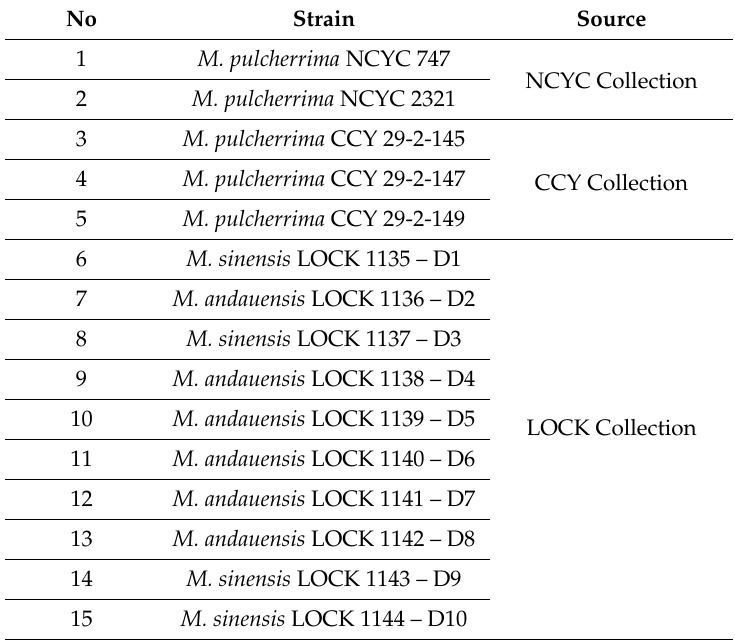
Table 1. Yeast strains used in the